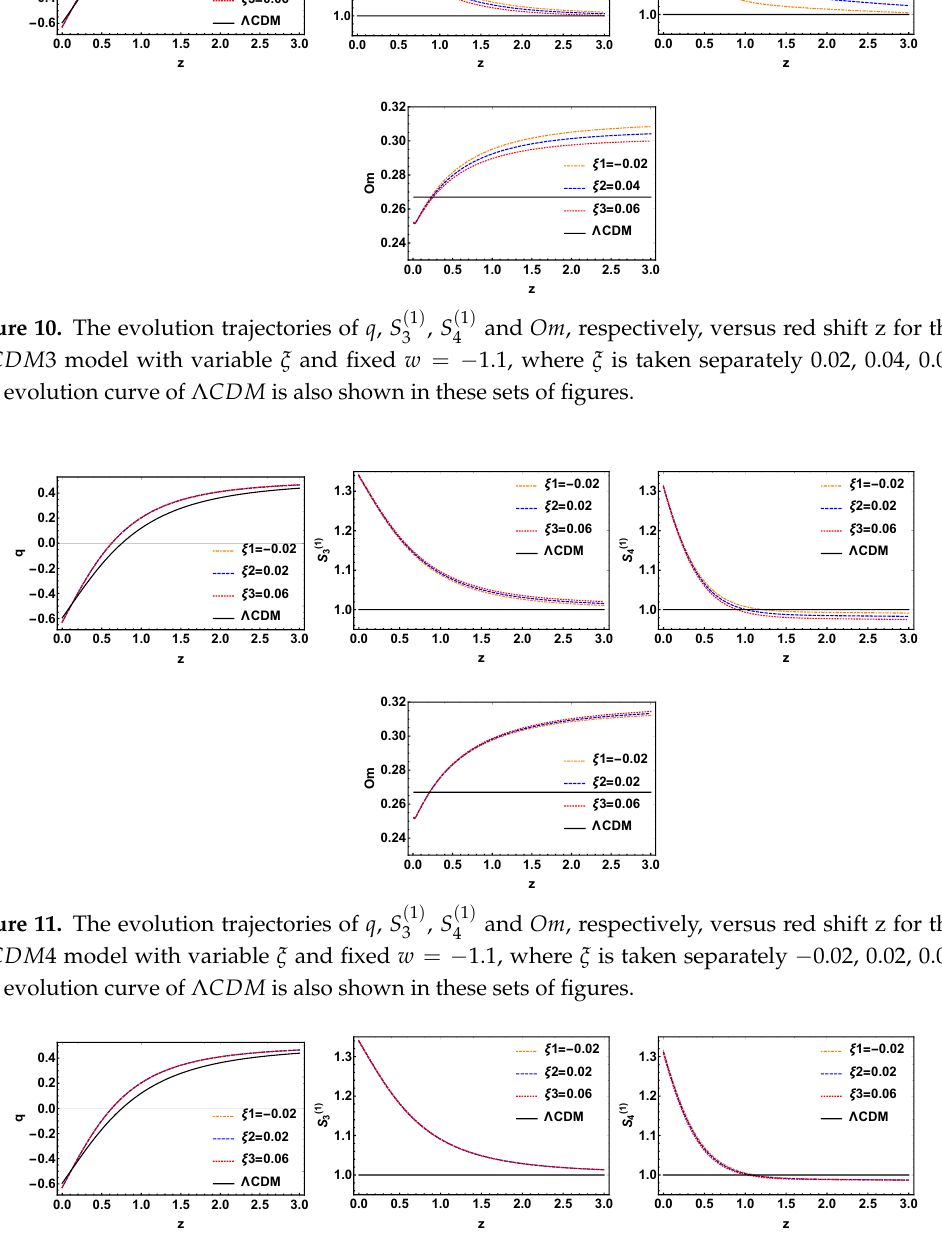
ξ 1 =- 0.02 ξ 2 = 0.02